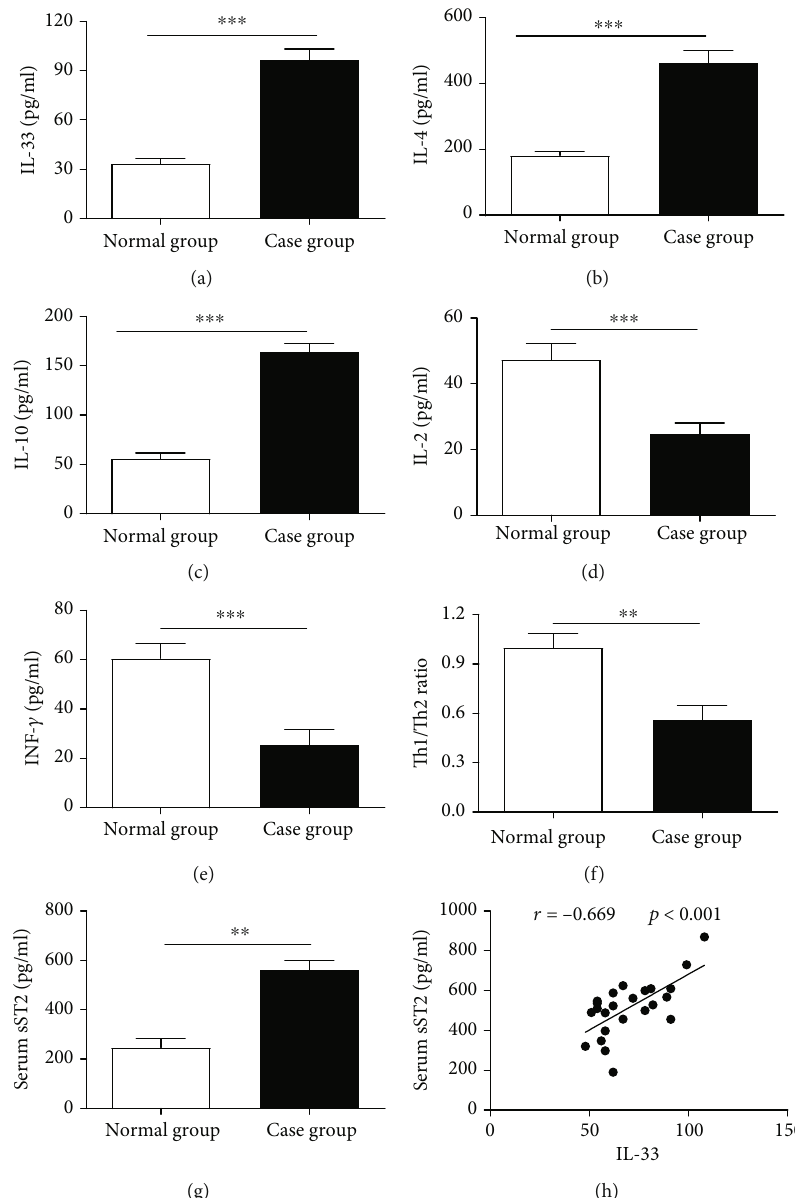
Figure 1: IL-33 expression is elevated, and Th1/Th2 ratio is imbalance in infants with acute bronchiolitis. (a) ELISA assay was used to detect the production of IL-33 in serum. (b, c) The levels of Th2-related cytokines IL-4 and IL-10 were examined by ELISA assay. (d, e) The levels of Th1-related cytokines IL-2 and INF- γ were examined by ELISA assay. (f) Cell fl ow cytometry was used to detect the ratio of Th1/Th2 cells. (g) ELISA assay was used to detect the production of ST2 in serum. (h) Correlation analysis is used to calculate the correlation between IL-33 and ST2 in serum. All data were expressed as the mean ± SD ( n = 3 ). Each value of ∗ p < 0 : 05 , ∗∗ p < 0 : 01 , and ∗∗∗ p < 0 : 001 was deem to have signi fi cant di ff